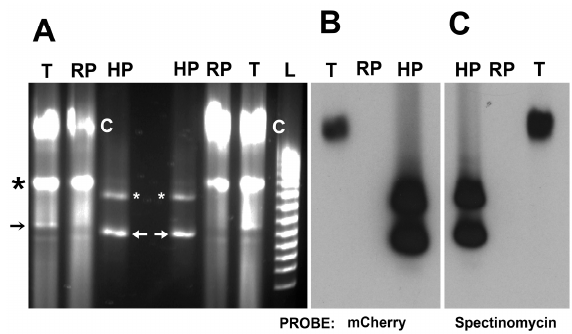
Figure 5. PFGE and Southern blot analysis of R. peacockii mutant obtained by transposon mutagenesis (HIMAR A7). Panel A. PFGE comparison of transformant (T) with wild type R. peacockii (RP). Black arrows point to position of linear monomers of the native 26 kbp pRPR and black asterisk indicates position of its conformational isomers. Lane L contains 5 kb ladder. HP lanes contain the 8.4 kb Himar1 plasmid (pCis mCherry-SS HIMAR1 A7) encoding mCherry and spectinomycin resistance ( aadA ) genes. White arrows point to position of supercoiled of pCis mCherry-SS HIMAR1 A7 and asterisks to its multimers; Panel B. Southern blot probed with digoxygenin labeled mCherry probe. Note probe binding in lane T to the region of the chromosome, to supercoiled and multimeric forms of pCis mCherry-SS HIMAR1 A7 plasmid bands in the HP lane, and absence of reactivity with the 26 kb pRPR; Panel C. Southern blot probed with the digoxygenin labeled spectinomycin resistance gene. The probe bound in lane T to the region of the chromosome, labeled the himar1 plasmid in the HP lane, but did not react with the 26 kb pRPR in lane RP. This is consistent with results shown in Panel B.